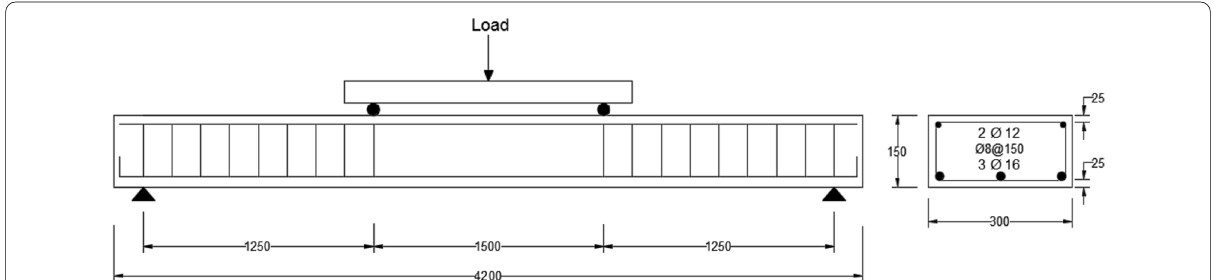
Fig. 5 Details of beam dimensions and